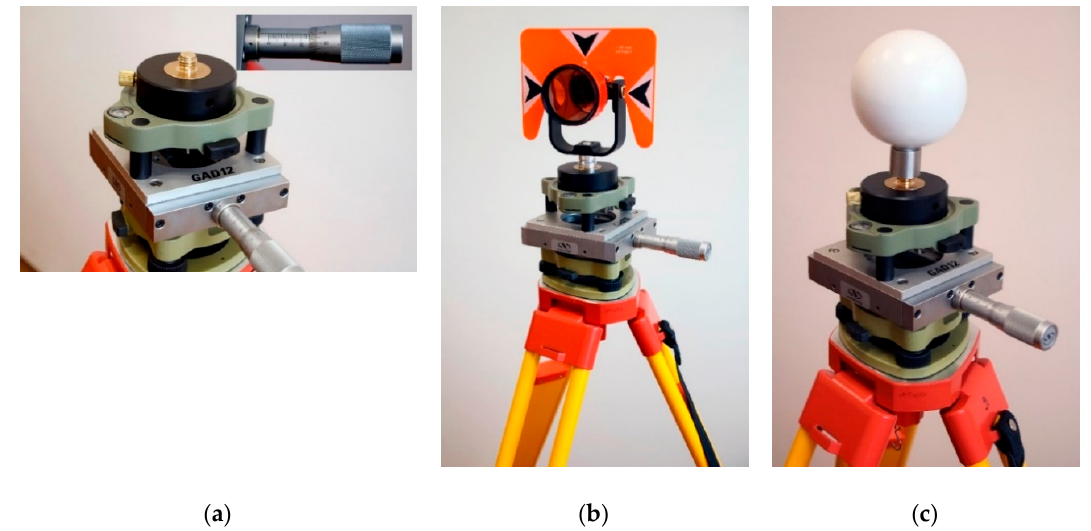
Figure 5. Precision translation stage with a ( a ) rotated adapter and reference objects on the precision translation stage. ( b ) Prism; ( c ) the measurement sphere.